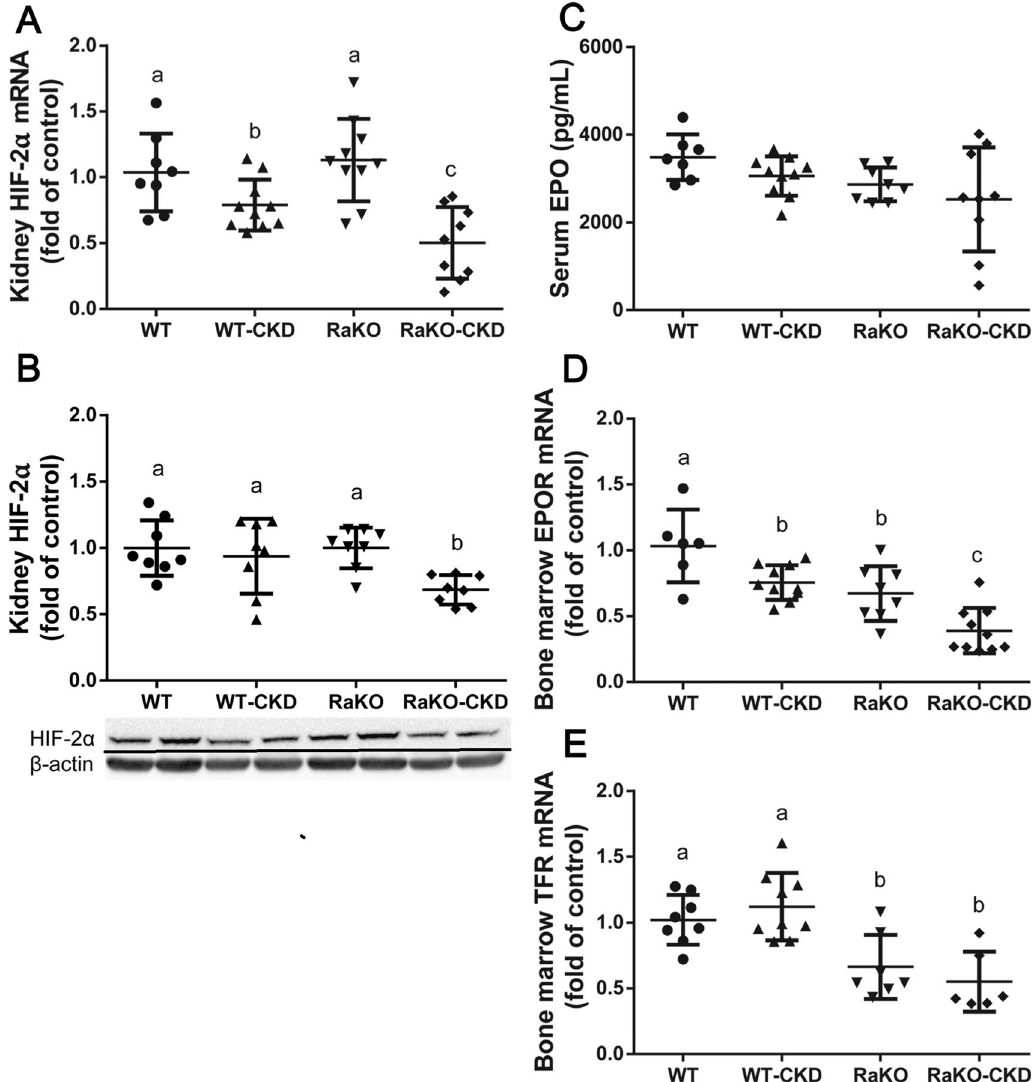
Figure 4. HIF2-EPO-EPO-R response of CKD mice with uncontrolled IL1 expression. Experimental groups include: wild type mice on a regular (WT) or adenine diet (WT-CKD), IL1-R antagonist knockout mice on regular diet (RaKO) or adenine (RaKO-CKD). Kidney hypoxia-inducible factor 2α (HIF2a) mRNA levels (A) and protein levels (normalized for β-actin). The lower panel shows a representative gel (B) . Serum erythropoietin (EPO) levels (pg/mL) (C) . Bone marrow EPO receptor (EPOR) (D) and transferrin receptor (TFR) (E) mRNA levels. n = 6–10 per group. Different letters above bars indicate a significant difference between groups, similar letters indicate no significant